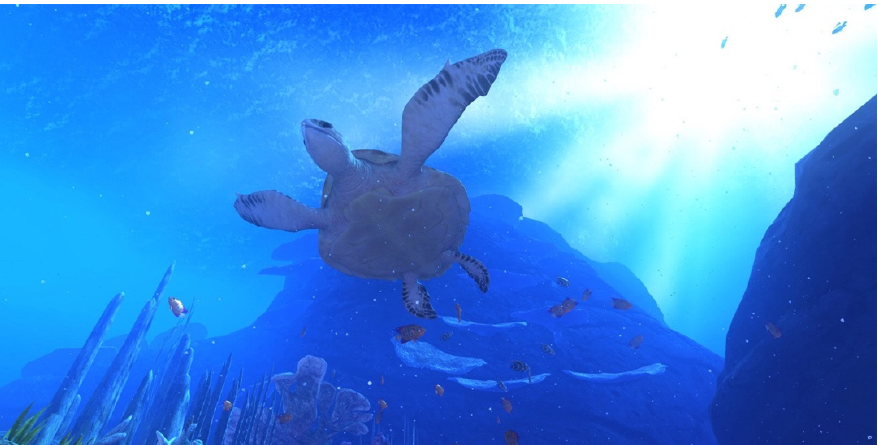
Figure 3. Screenshot of the acclimatization experience proposed (TheBlue) before session 2 placed at the sea.